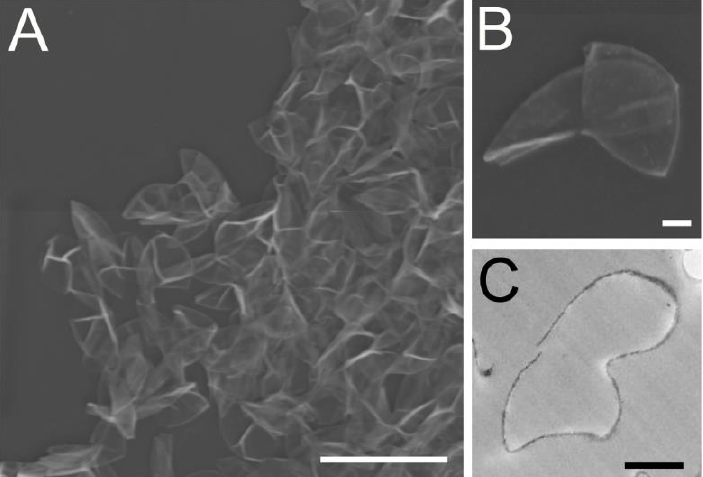
Figure 1. Scanning panels ( A , B ) and transmission panel ( C ) electron micrographs of washed Chlorella cell wall fraction. Scale bars in the panels ( A – C ) represent 10 µm, 1 µm, and 1 µm, respectively.